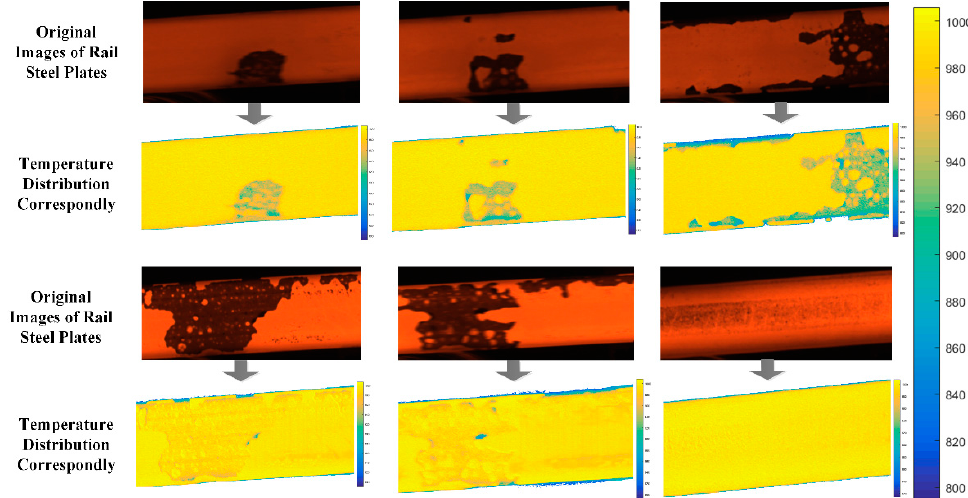
Figure 6. The part of radiation images and temperature distributions of rail steel plates during rolling processes (online version in color).